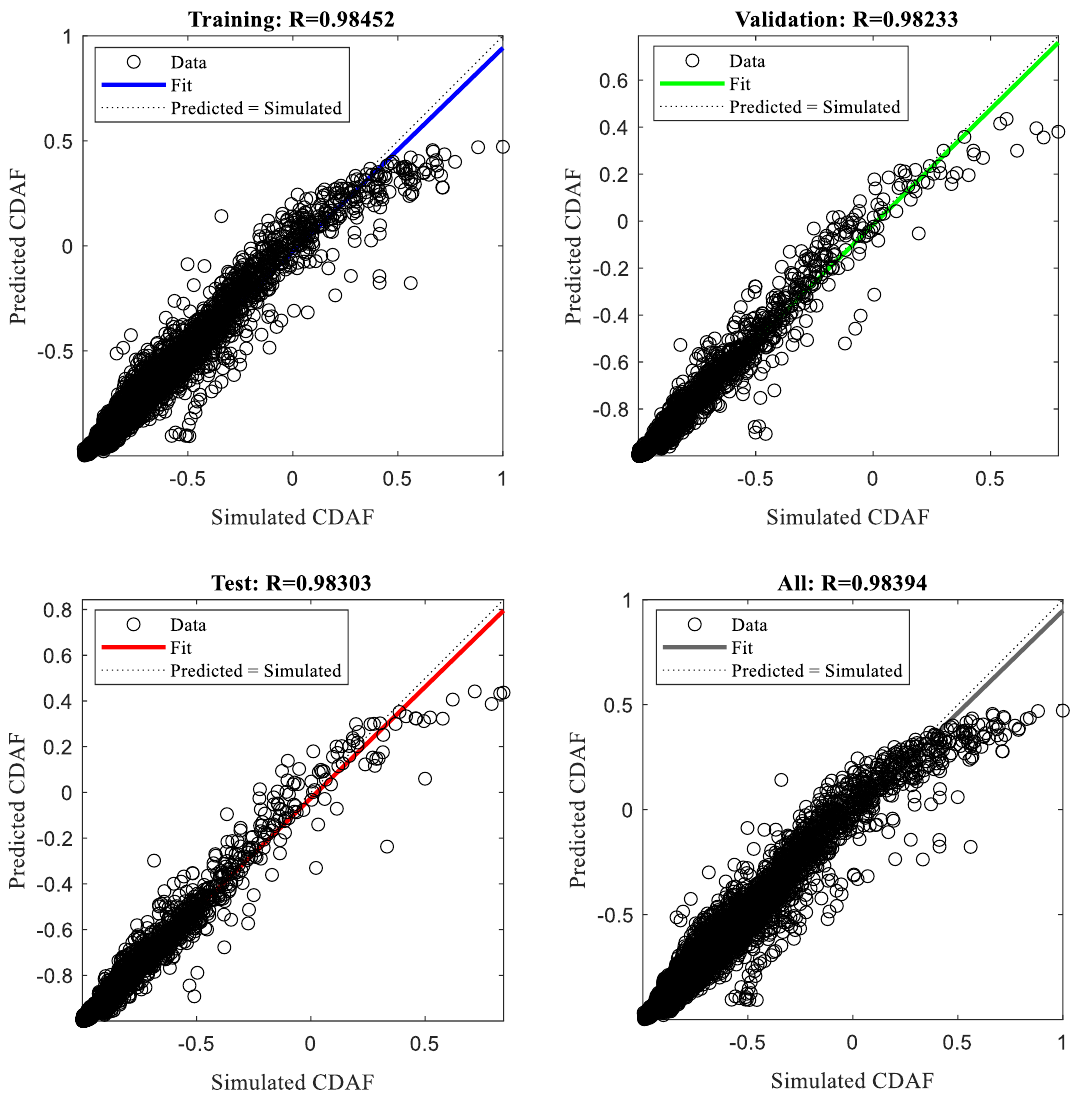
Figure 18. Simulated and ANN’s predicted CDAF for an irregular building model. Table 6. Performance of ANN model.